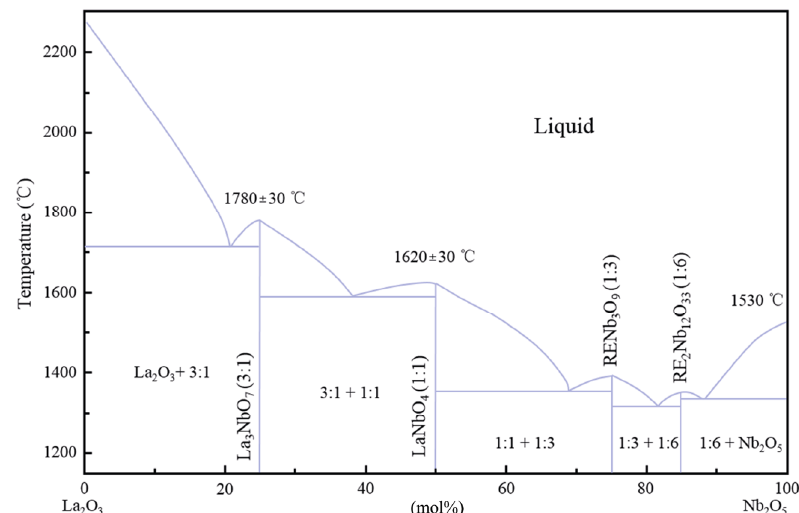
Fig. 7 Binary phase diagram of the La–Nb–O system. Reproduced with permission from Ref. [71], © Optical Society of America